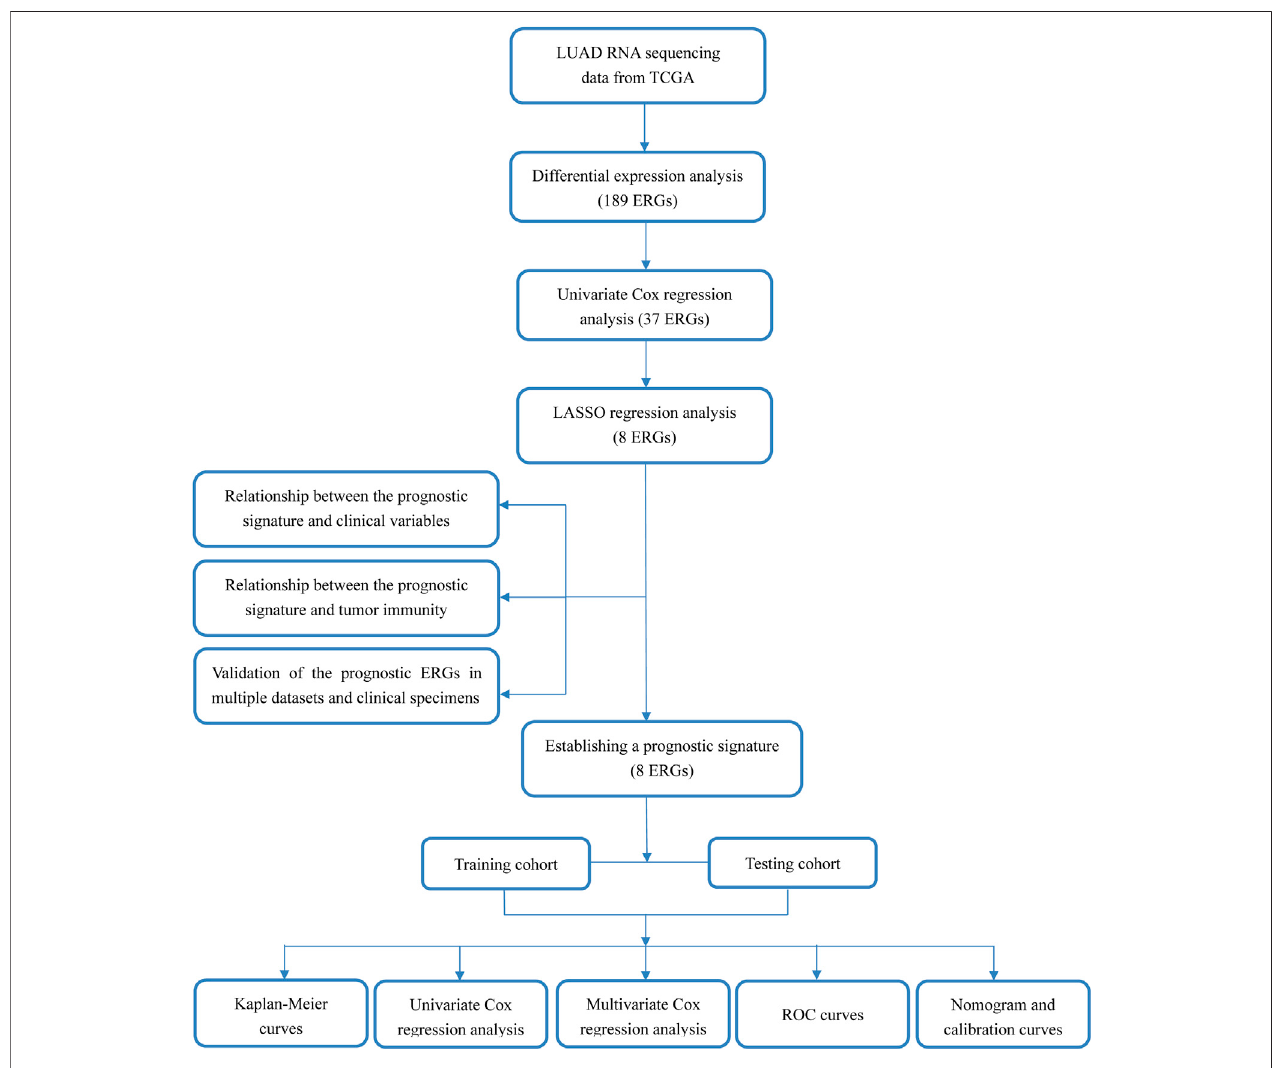
FIGURE 1 | Work fl ow of this